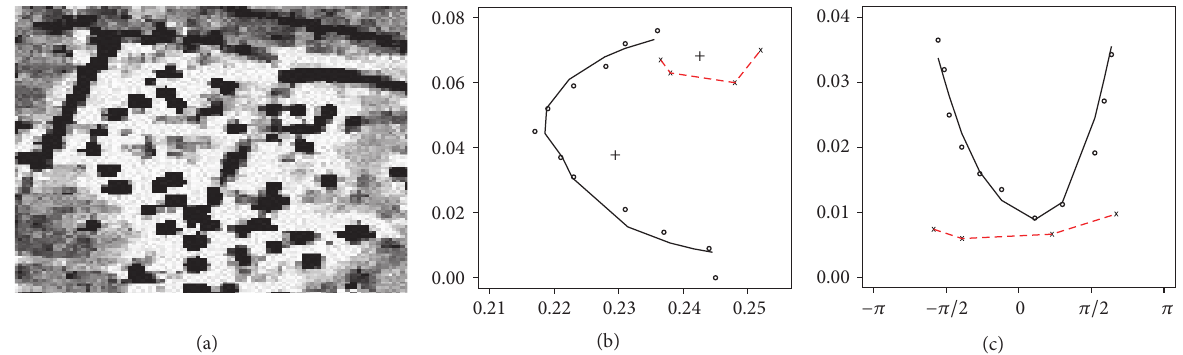
Figure 10: (a) Magnetic survey data for part of an iron-age archaeological site; (b) selected pits along with back-transformed fitted two-part spline curve; (c) polar coordinates and fitted two-part spline